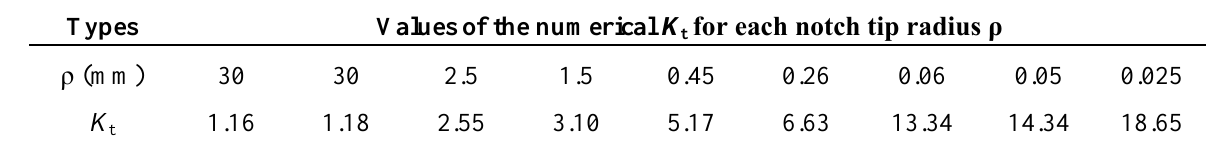
for each notch tip radius t